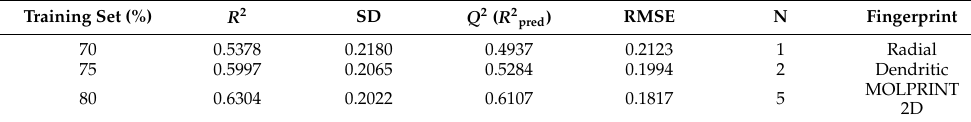
R 2 : coefficient of determination for the training set; SD: standard deviation; Q 2 : predictive correlation coeffi- cient for the test set ( R 2 pred ); RMSE : root-mean-square error for the test set predictions; N: optimum number of